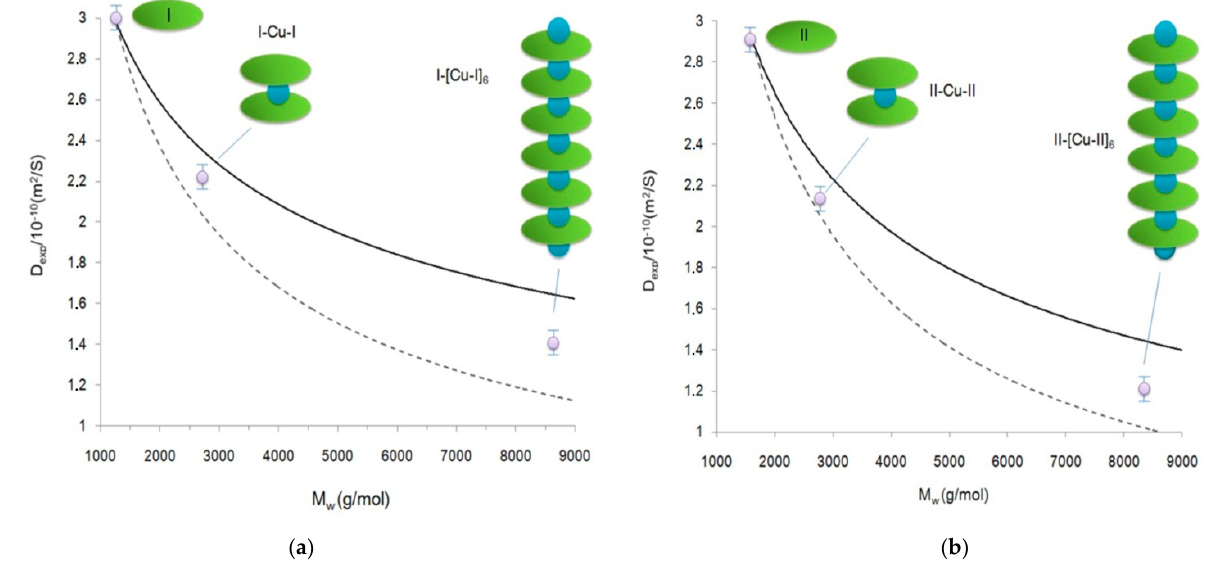
Figure 11. Graphical analysis of self-diffusion coefficients of the products of SnP(L) 2 interaction with Cu 2+ cations at the 1:1 and 1:5 ratios with monomer complexes taken as the reference standard: ( a )-I, ( b )-II. The solid lines represent the theoretical values calculated by the Formula 3.